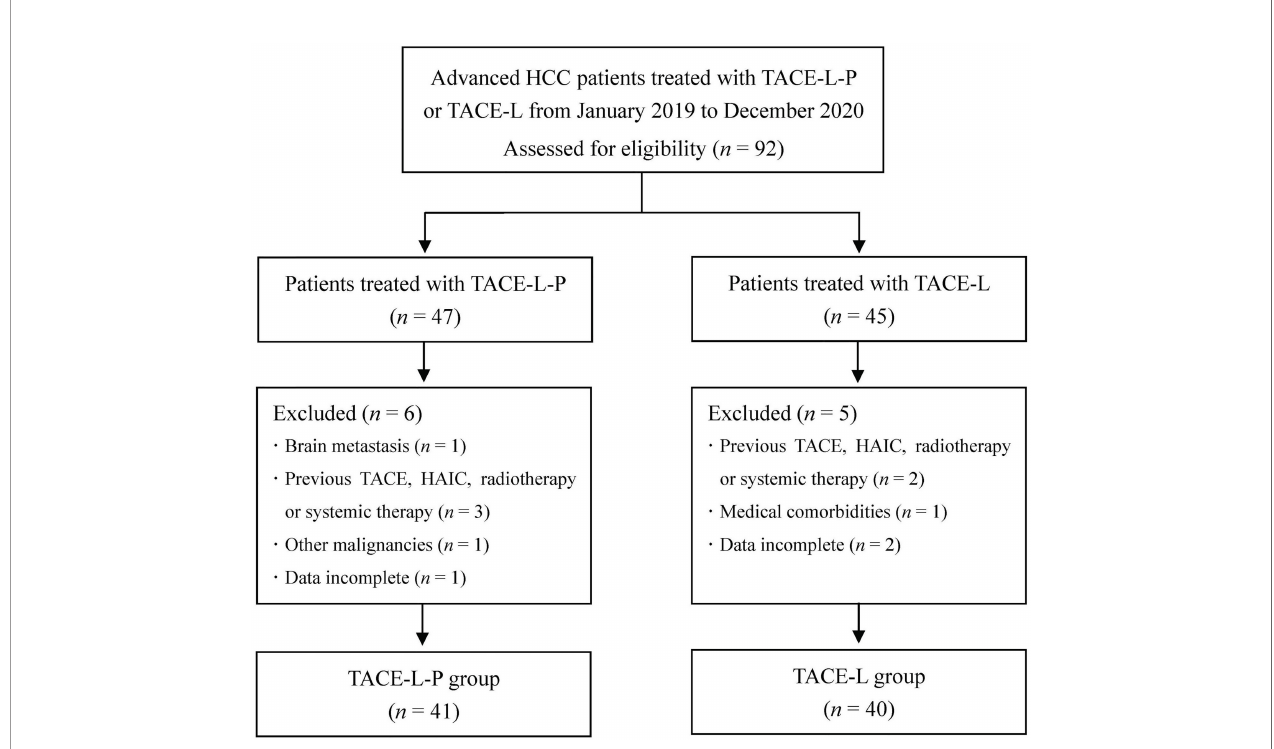
FIGURE 1 | Flow diagram of patient enrollment. HCC, hepatocellular carcinoma; TACE-L-P, transarterial chemoembolization combined with lenvatinib plus PD-1 inhibitor; TACE-L, transarterial chemoembolization combined with lenvatinib; TACE, transarterial chemoembolization; HAIC, hepatic arterial infusion